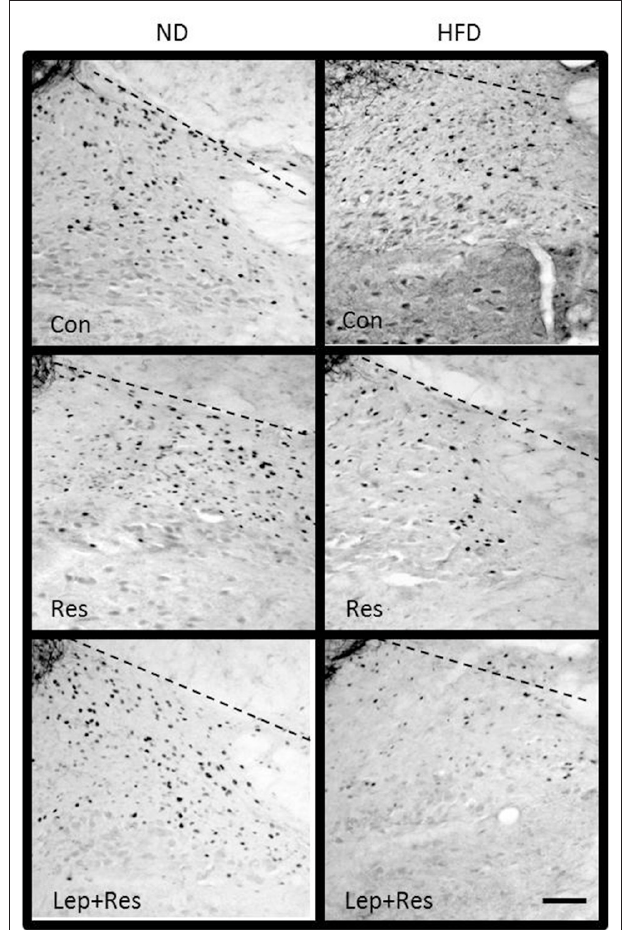
nucleus of the solitary tract of rats fed a high fat diet (HFD) and rats fed a normal diet (ND) following centrally administered saline (5 µ l; control), resistin (7 µ g) or leptin combined with resistin. Scale bar = 100 µ m. The rostrocaudal levels of the sections counted were at ∼ 13.7–14.1mm caudal of